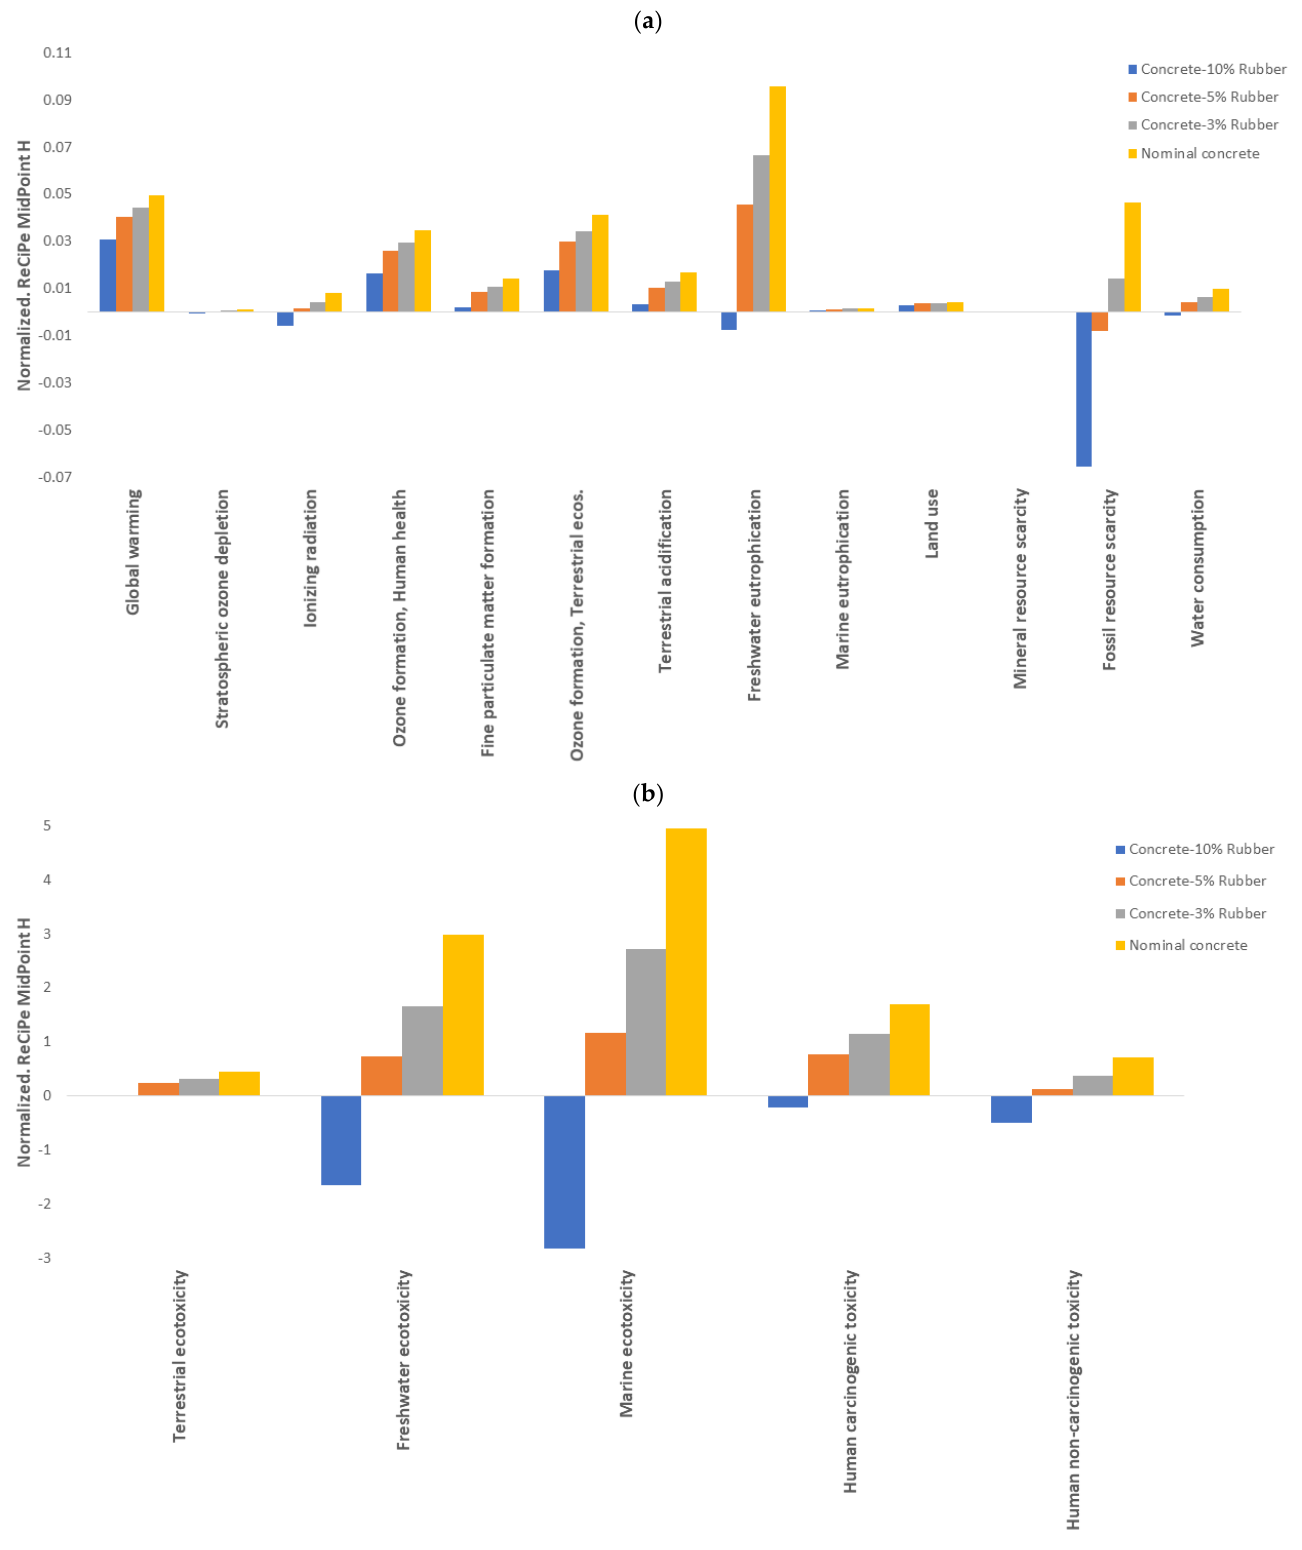
Figure 9. Normalized results for 1 m 3 of the concrete mixes: ( a ) low impact categories; and ( b ) higher impact categories.